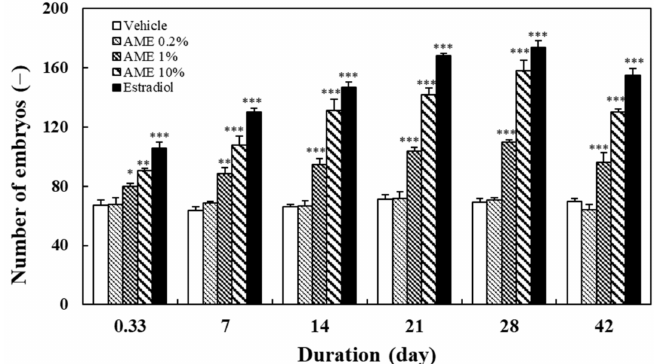
Figure 2. Effects of the supplementation of AME on the fertilized egg production. Each dataset is represented by five independent repeated experiments. Statistical differences compared to the vehicle group were tested using one-way ANOVA. Levels of significance are expressed as * p < 0.05, ** p < 0.01, and *** p < 0.001.